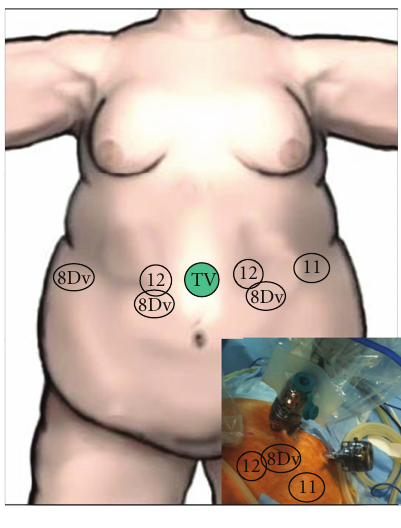
gastric curvature, 5 cm proximally to the pylorus, towards the lateral edge of the bougie. This manoeuvre was performed twice. The right arm was again docked and the left robotic arm was switched to the left lateral 11 mm trocar. This manoeuvre allowed the decannulation of the right arm from the 12 mm trocar without moving the robot and can be performed within a few seconds. The table surgeon inserted a stapler loaded with blue cartridges in order to divide the sleeve up to the end of the upper part. The stomach was then removed from the cavity through the 12 mm trocar. staple line. A robotic needle holder was used for this